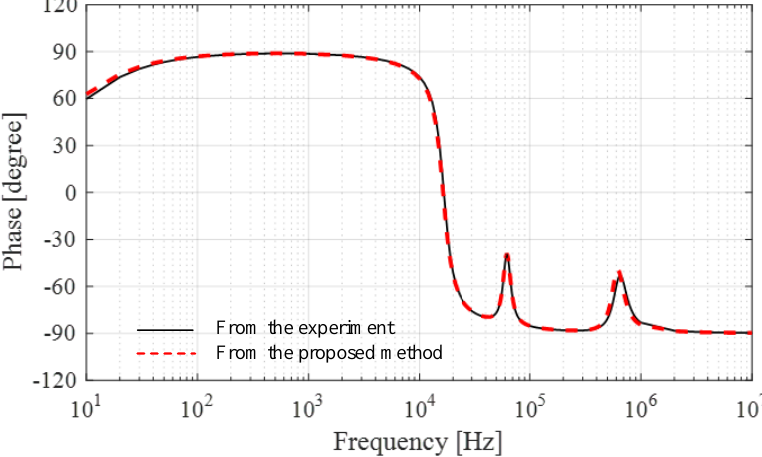
Figure 21. Phase of input impedances of the transformer winding from the measurement and by the proposed method.